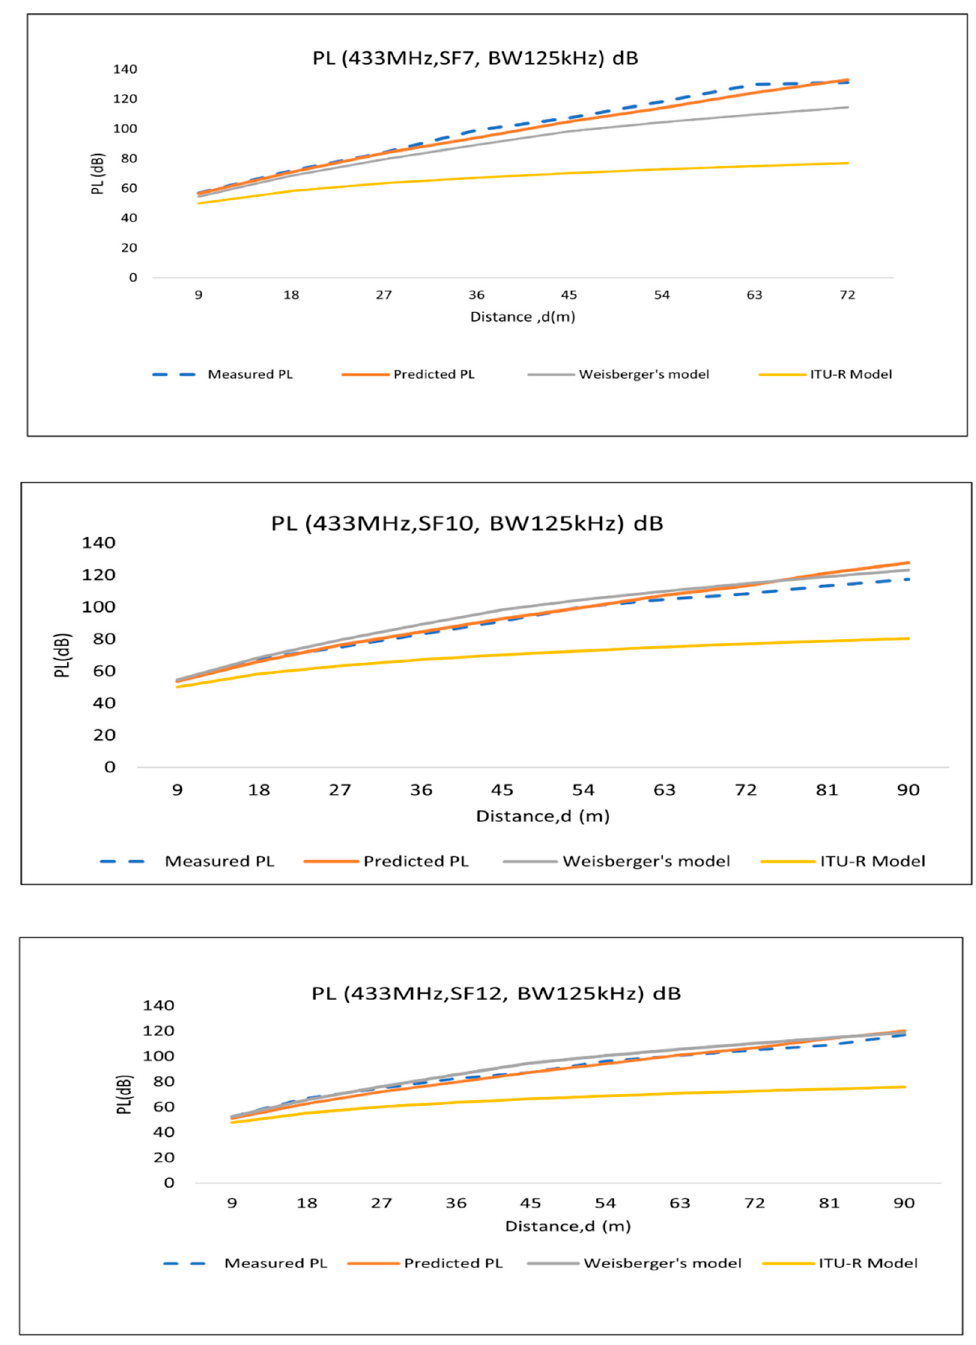
Figure 9. Path-loss comparison of 125 kHz bandwidth LoRa settings. In this study, RSS data were collected for 433 MHz LoRa channels and analyzed. Since there are similarities between the measured data of BW 125 kHz and BW 250 kHz, among these two BWs, 125 kHz data were chosen for the comparison. Therefore, the comparison is presented for BW 125 kHz and BW 500 kHz. Again, SF7, SF10, and SF12 data are used for comparison to see the path-loss models’